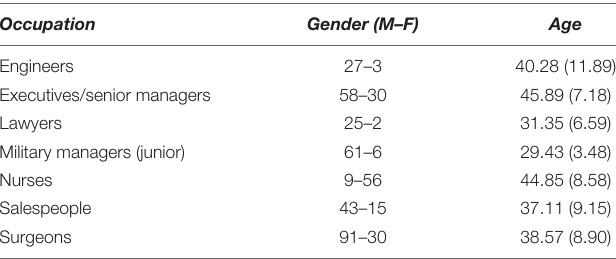
TABLE 2 | Gender and age information for the seven comparison samples in study